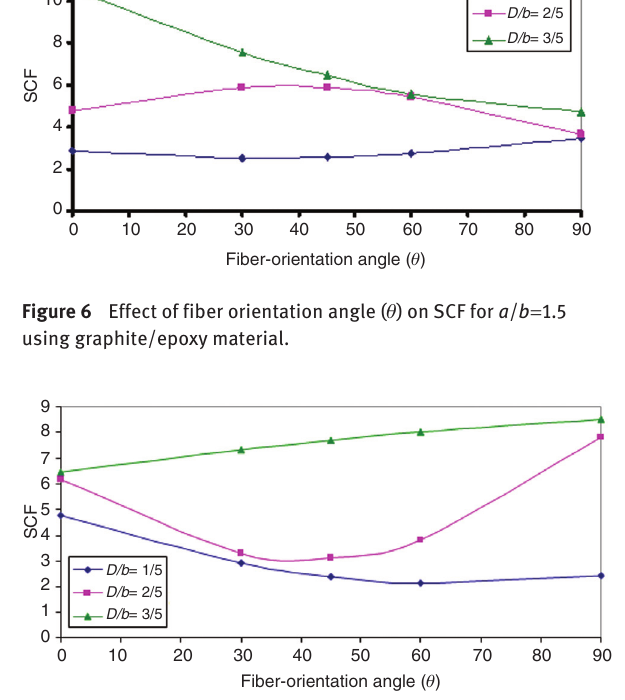
Figure 7 Effect of fiber orientation angle ( θ ) on SCF for a / b = 2 using graphite/epoxy material.